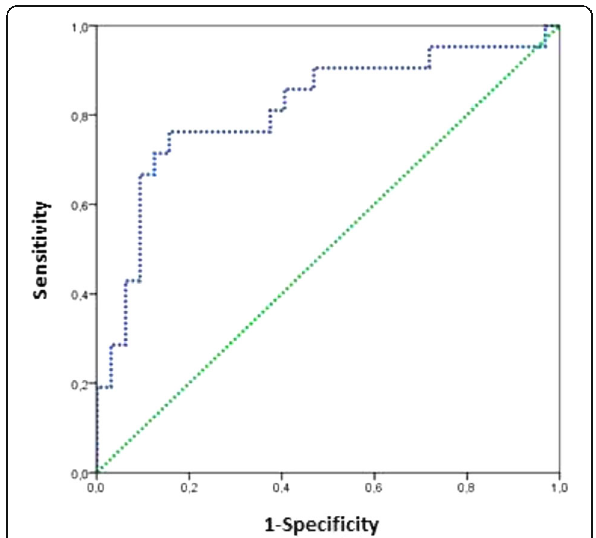
Fig. 2 (abstract 0123). Prognostic value of SChEA on the 5th day of septic shock (area under the curve